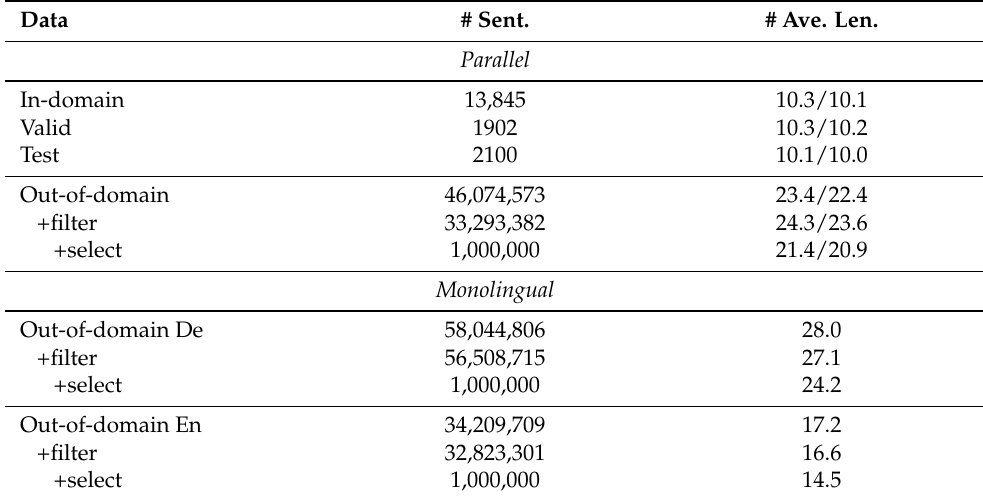
Table 2. Data statistics of En-De after pre-processing. The in-domain/valid/test set is speaker- ignored combined and their average lengths are counted based on